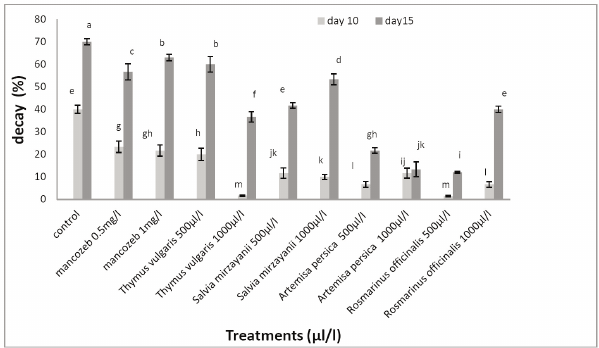
Fig. 2 - Suppressive effect of the Thymus vulgaris , Salvia mir- zayanii , Artemisia persica and Rosmarinus officinalis EOs tested at 500 and 1000 μl/l on mangos decay after 10 and 15 days of storage compared to ‘mancozed’ (0.5 and 1.0 mg/l). Bars indicate the SD of the mean. Different let- ters indicate significant differences in mean values (p